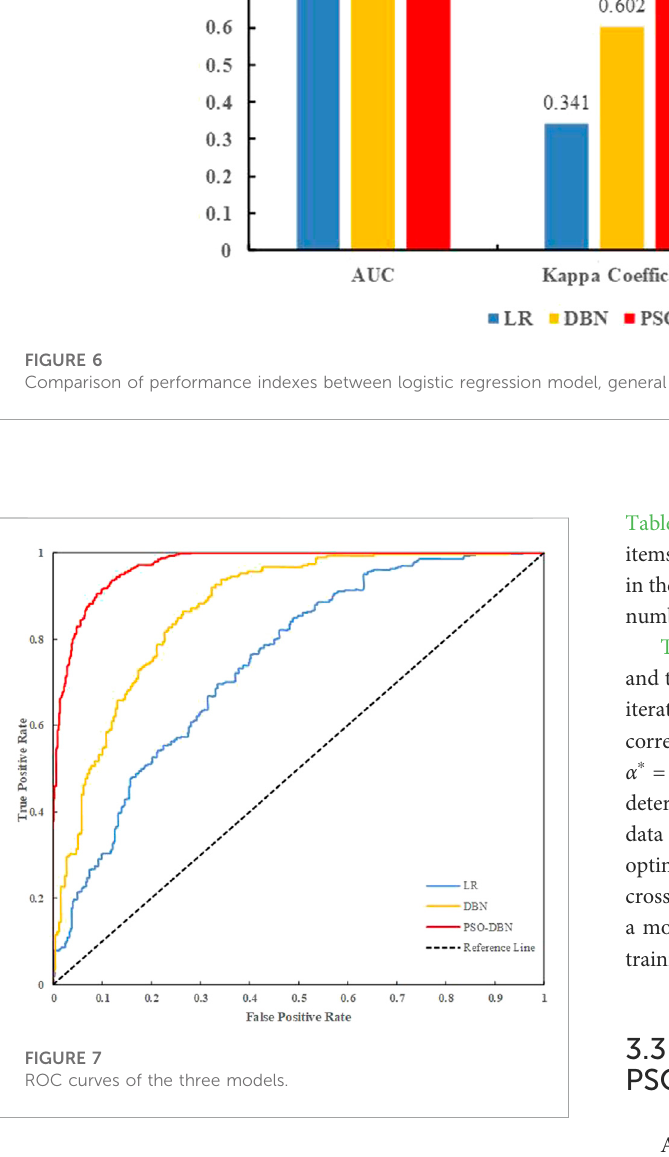
FIGURE 7 ROC curves of the three